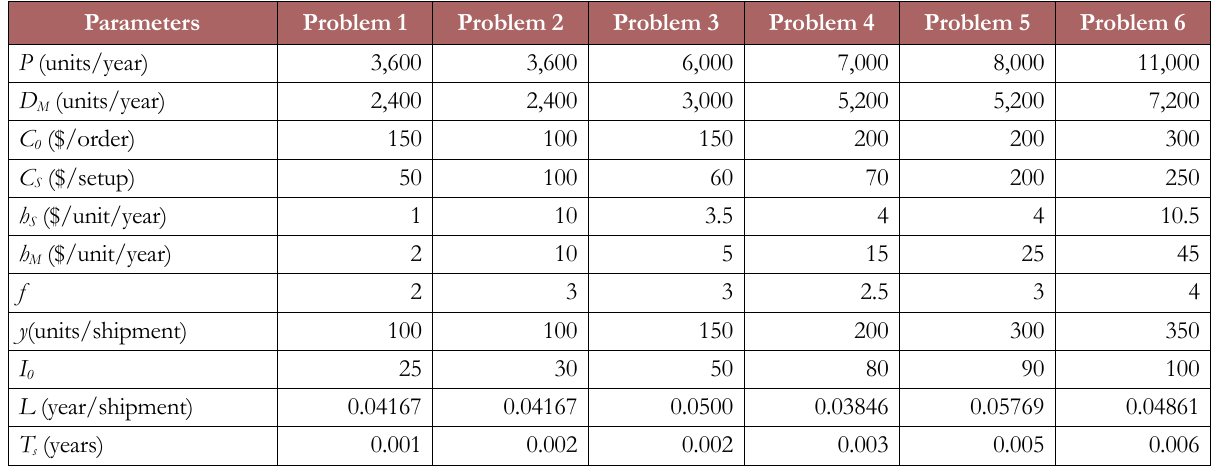
Table 1. Data set for computation of Problem IM